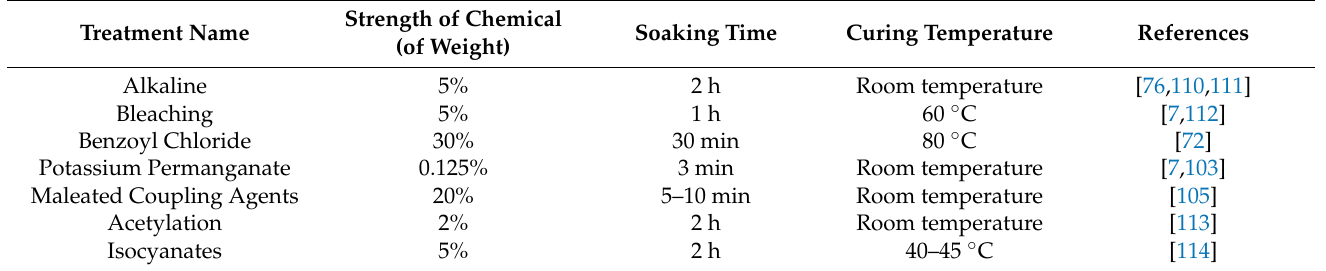
Table 3. Strength of chemicals and soaking time of different chemical